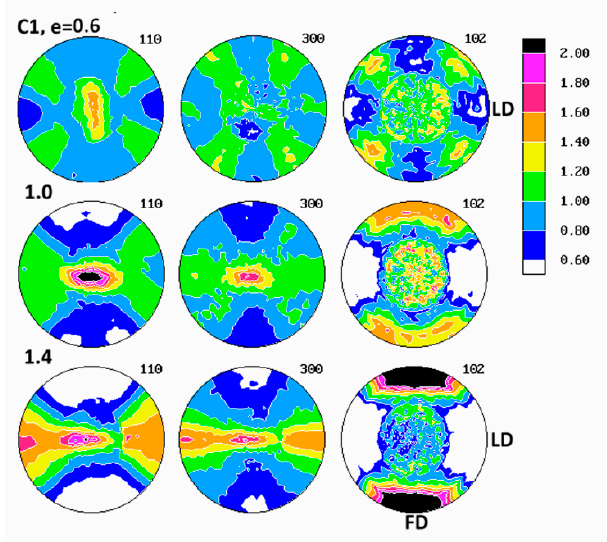
Figure 9. Selected normalized pole figures of the (110) (300) and (102) crystallographic planes (Form I) determined for samples of C1 copolymer compressed in plane-strain to the true strain indicated.